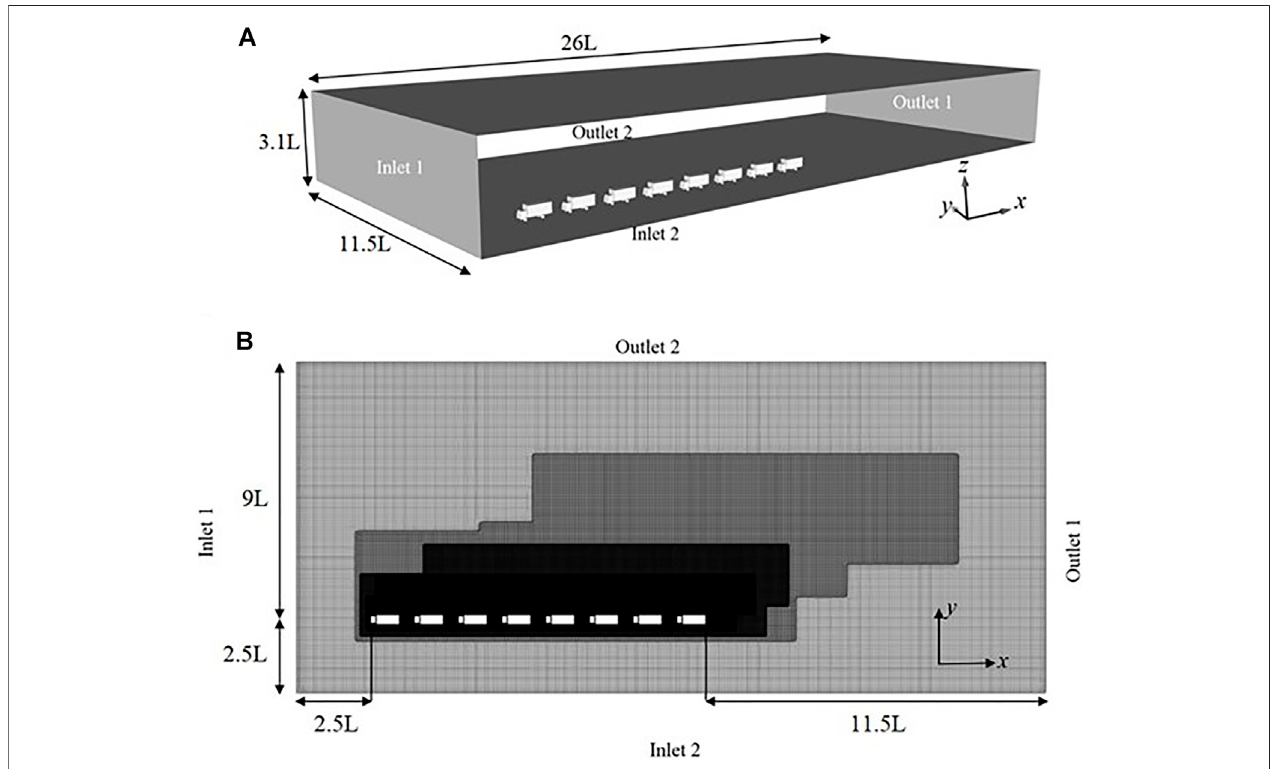
FIGURE 2 | (A) Geometry and dimensions of the computational domain (B) The dimension and illustration of the computational mesh created at the cut plane normal to the z -axis at 0.1 m above the ground.